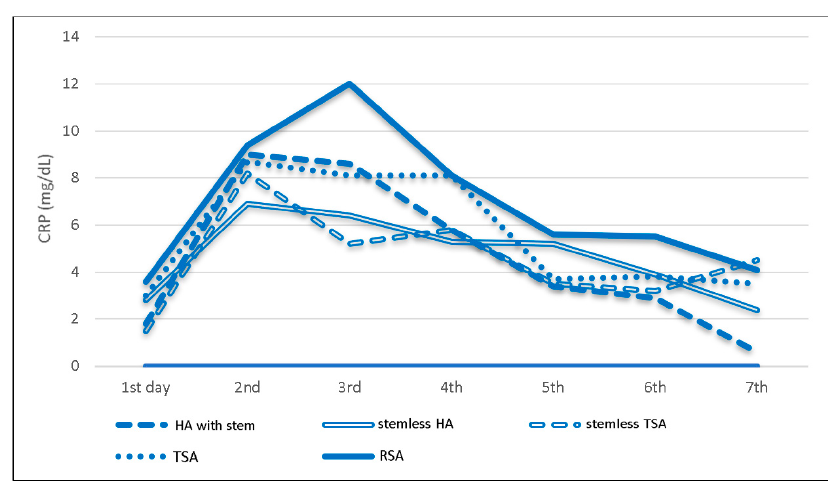
Figure 5. Prosthesis-specific mean C-reactive protein levels and trends following shoulder arthroplasty. Table 3. Overview of mean postoperative C-reactive protein levels in mg/dL on different days following shoulder arthroplasty according to the different subgroup analysis. Patients